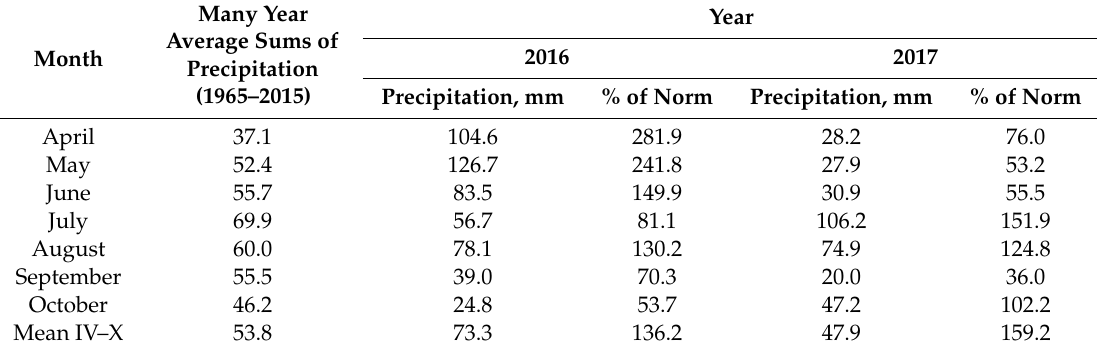
Table 5. Monthly sums (mm) of precipitation during the growing season in 2016 and 2017, according to Michurinsk Meteorological